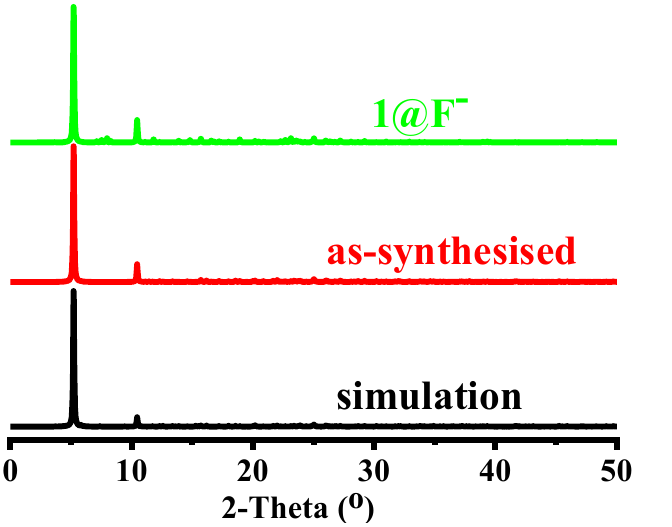
Figure 11. PXRD profile of the as-synthesized 1 and the simulated result as reference as well as luminescence sensing analytes.